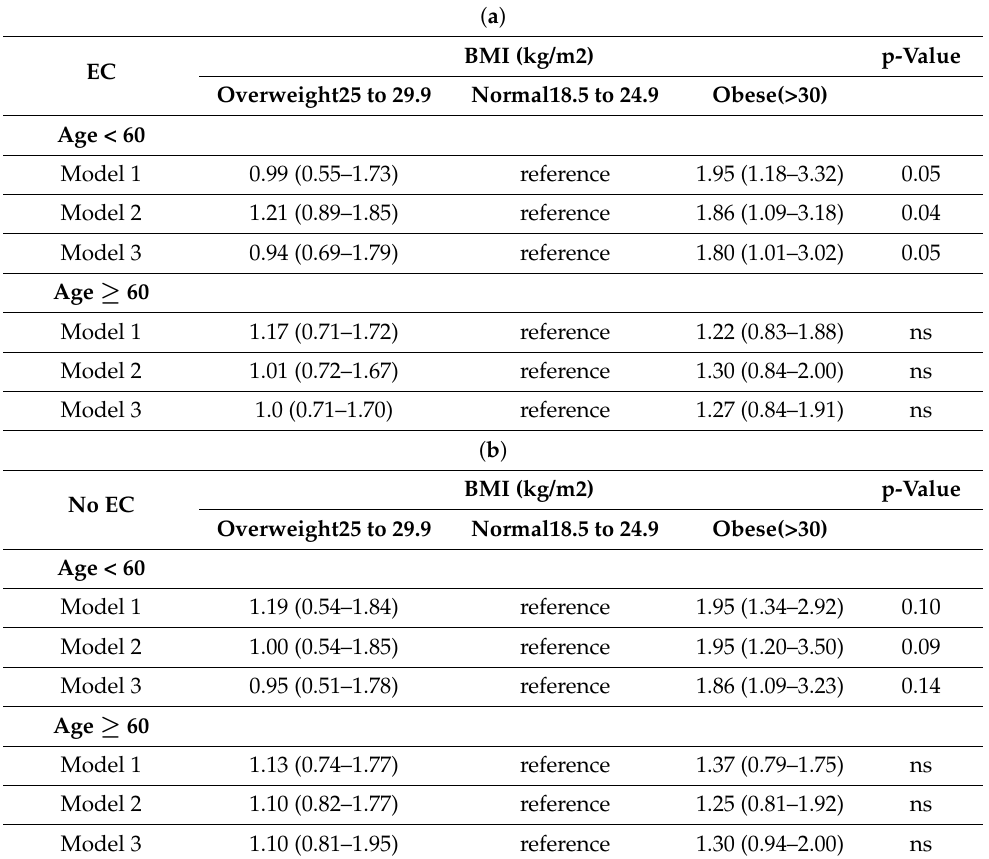
Table 2. Hazard ratios (HRs) (95% CI) for atrial fibrillation (AF) according to body mass index (BMI) stratified by age in the endometrial cancer (EC) ( a ) as well as in the non-EC ( b ) group. ( a